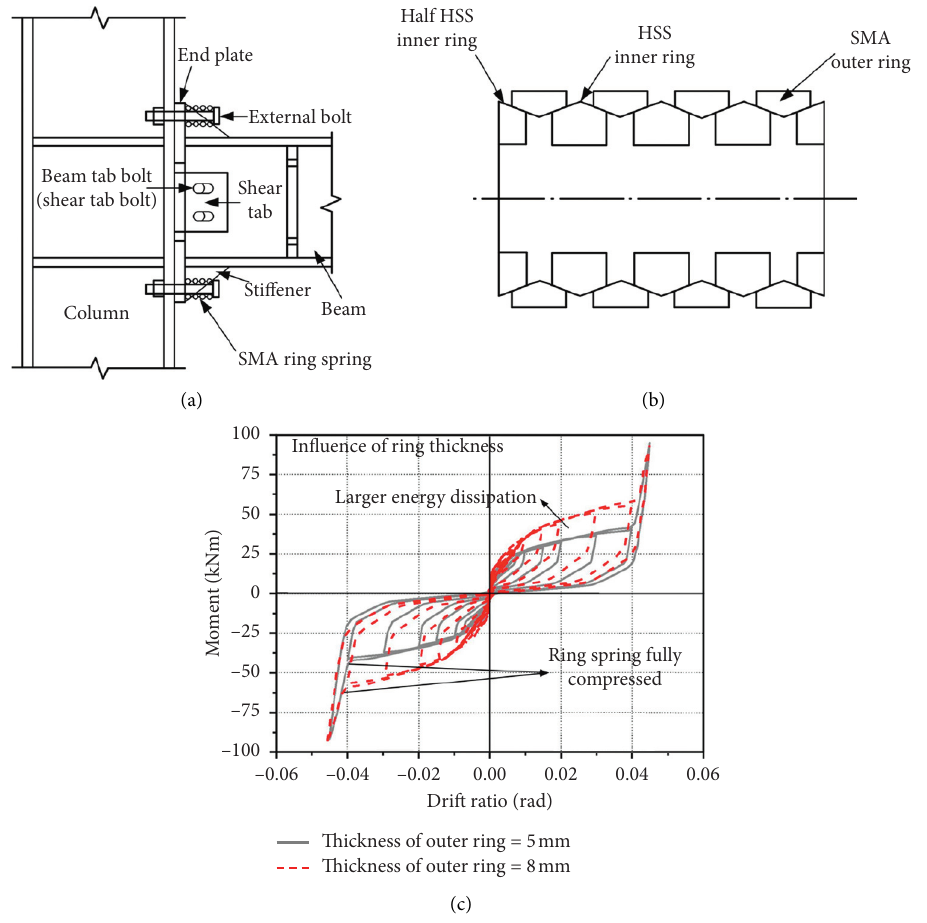
Figure 11: Schematicand behaviorof theproposedconnection and SMAring spring: (a)connectiondetail;(b) SMAring spring; (c)moment-drift ratio relationship (adapted from [50]).